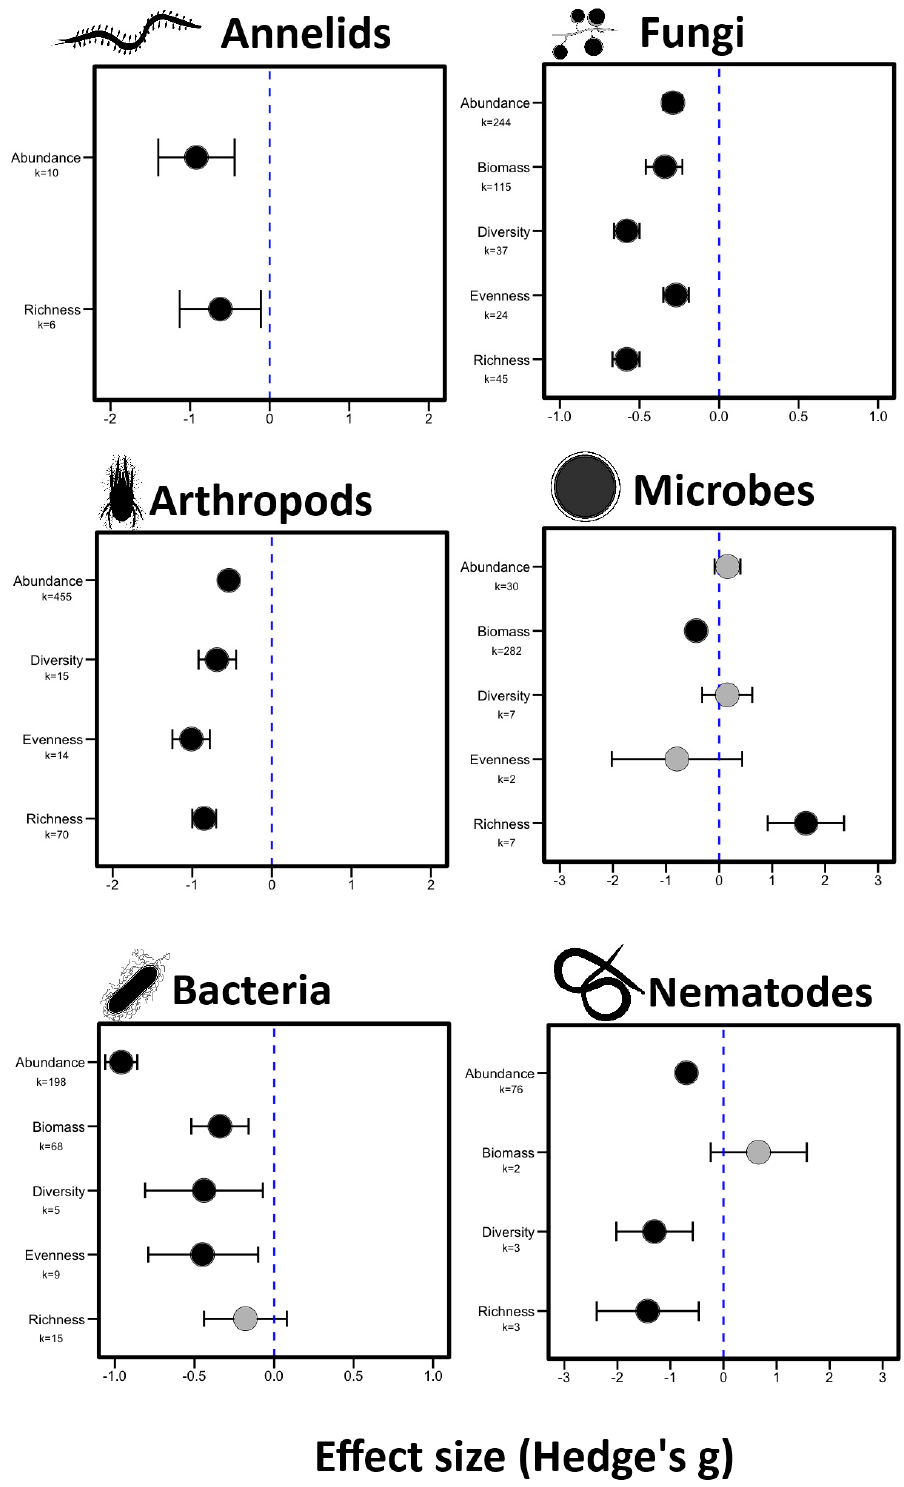
Figure 3. Effect of fire on abundance, biomass, diversity, evenness, and richness of belowground faunal groups. The x-axis shows overall effect size (Hedges’ g). k is the number of observations included in each analysis. Circles denote the Hedges’ g value and lines denote the 95% confidence intervals (CI) for each Hedges’ g value. Black circles represent significant effects whist grey circles show no significant effects the Hedges’ g value.